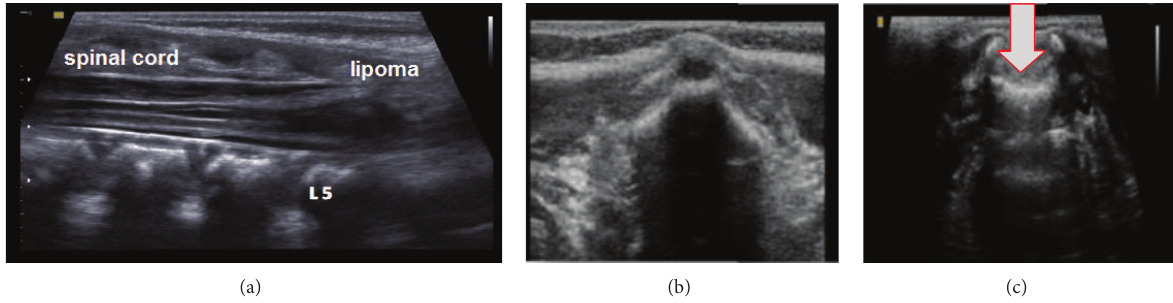
Figure 2: (a) Ultrasonography in the sagittal plane, showing a medullary cone extending as far as the sacral vertebrae, with a hypoechoic solid formation inside the canal (lipoma); (b) ultrasonography in the axial plane at the level of the upper lumbar spine (L1), showing a closed medullary canal; (c) ultrasonography in the axial plane at the level of the lower lumbar spine (L5), showing discontinuity of the posterior bone layers (white